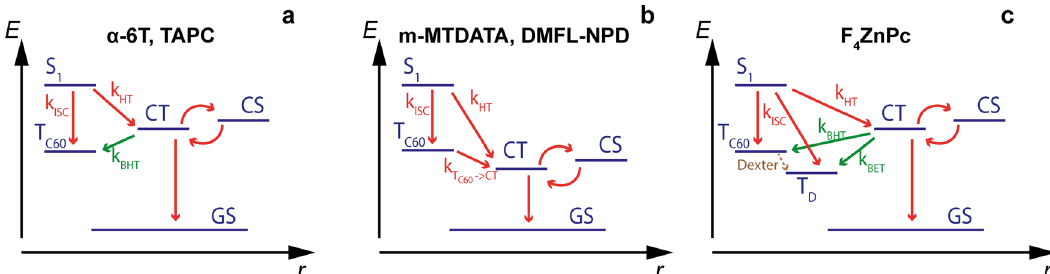
Fig. 3 Schematic representation of the different photophysical pathways occurring in the studied systems. a Pathways for E CT > E T1 , b for E CT < E T1 , and c when both the donor and C 60 Triplets ( T C60 = T 1 ) are lower in energy than the CT state. The donors for which each case occurs are indicated above and the key rates ( k ) of pathways discussed in the text are labeled.